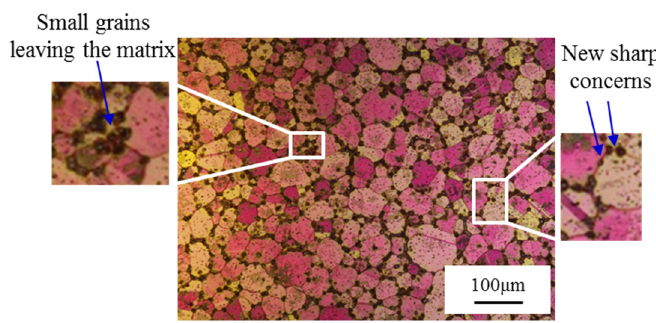
Figure 5. Microstructures of rotary swaged C5191 at the early stage of IHT.